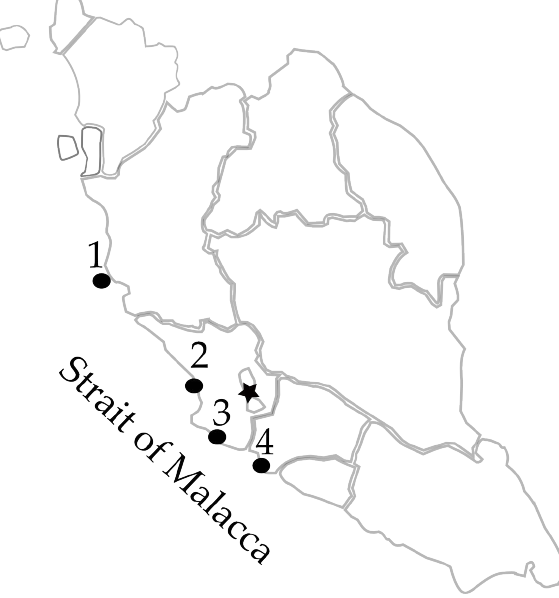
Fig. 1. Location of sampling sites Peninsular Malaysia. ? =Kuala Lumpur (laboratory), • =sampling sites. (1) Seaweed farm, Pangkor Island, Perak. (2) Shrimp farm, Kuala Selangor, Selangor. (3) Man- groves, Morib, Selangor. (4) Port Dickson, Negeri Sembilan;